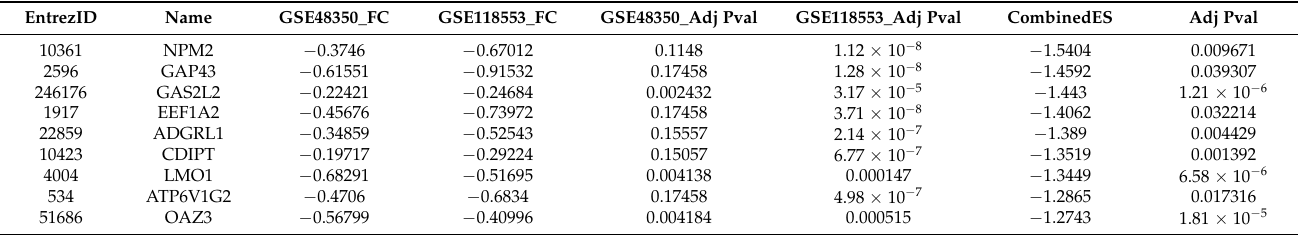
Table 2. Top 20 downpregulated genes in AD entorhinal